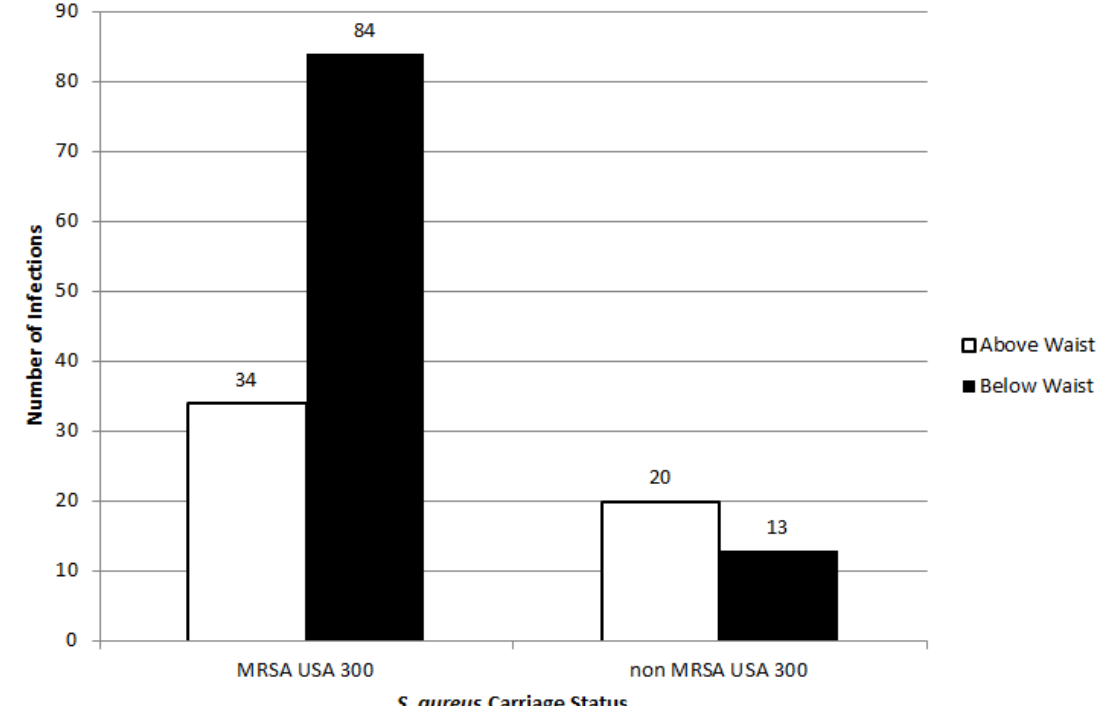
Figure 2. S. aureus carriage strains and body locations of skin and soft tissue infections. SSTI, skin and soft tissue infection; MRSA, methicillin resistant Staphylococcus aureus